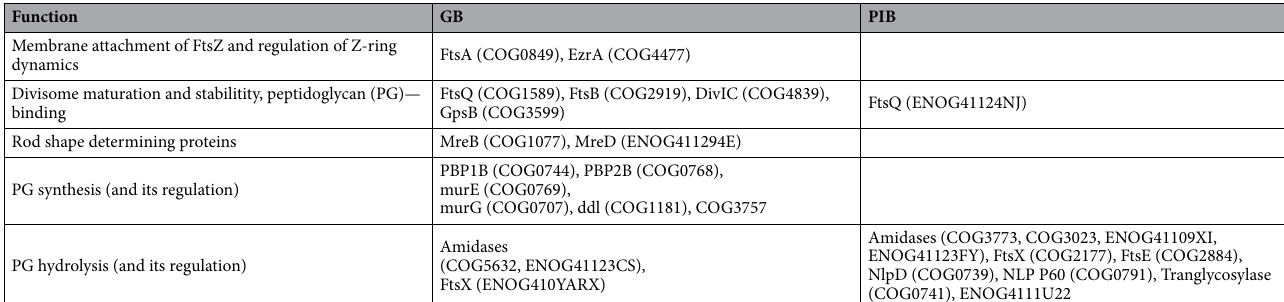
Table 4. COGs/NOGs involved in cell cycle control, cell division, and chromosome partitioning in the GB and PIB